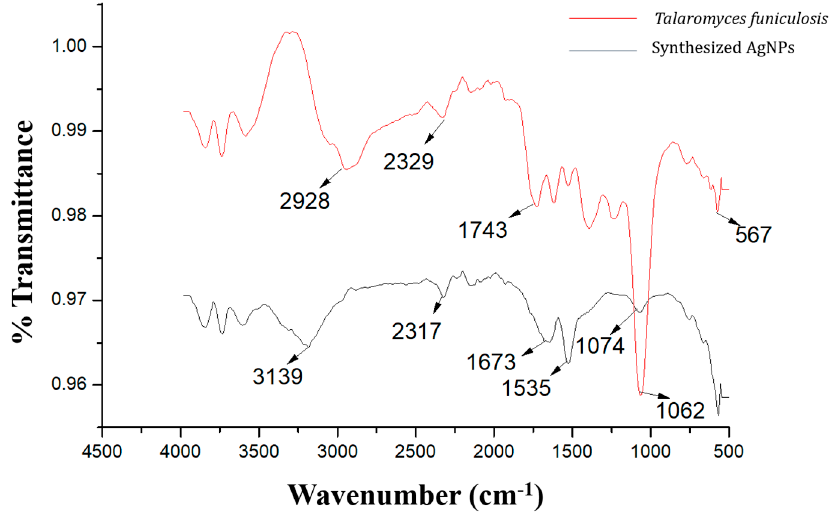
Figure 5. ATR-FTIR spectrum of T. funiculosus extract and T. funiculosus –AgNPs.